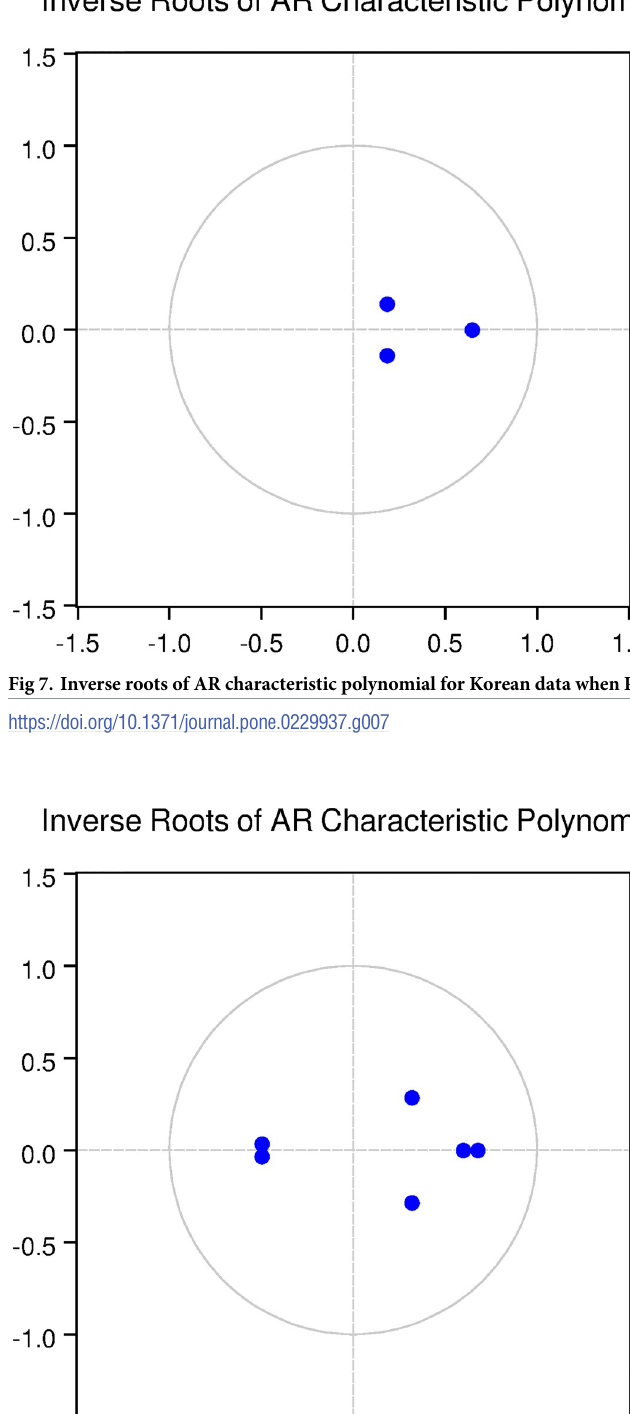
PLOS ONE | https://doi.org/10.1371/journal.pone.0229937 April 2,